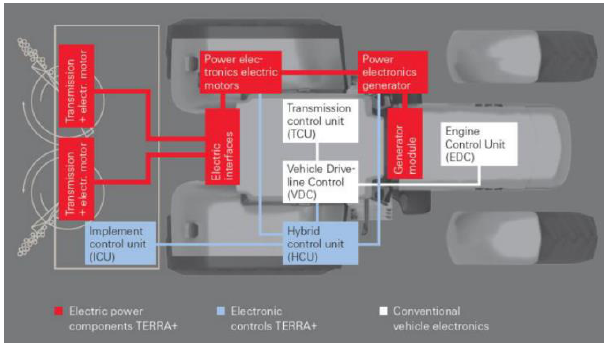
Fig. 19. ZF TERRA+ possible architecture [23]